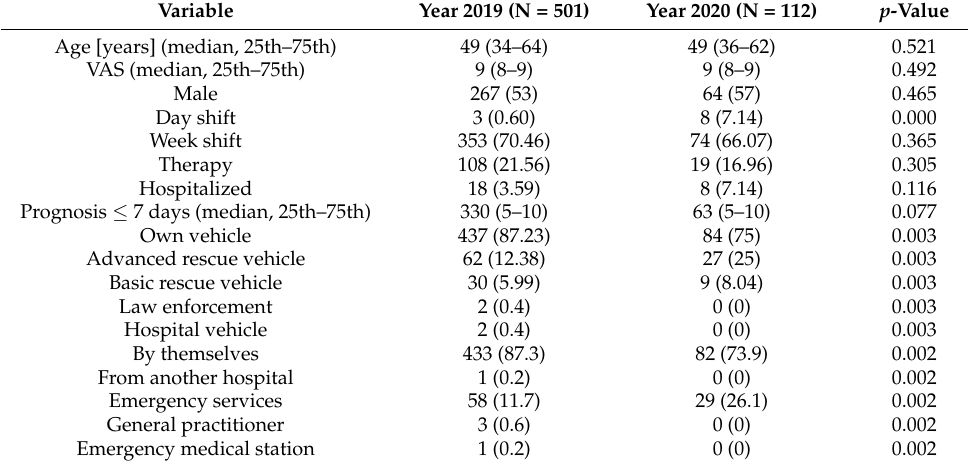
Table 2. Description of patients by yearly cohort; data are reported as N (%) unless otherwise specified.